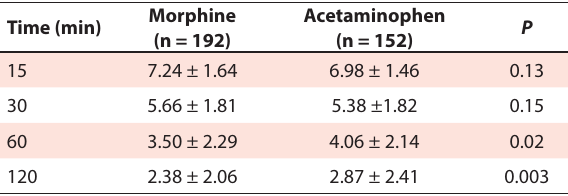
Table 2. Comparison of pain severity between the two groups in 15, 30, 60, and 120 minutes after treatment administration